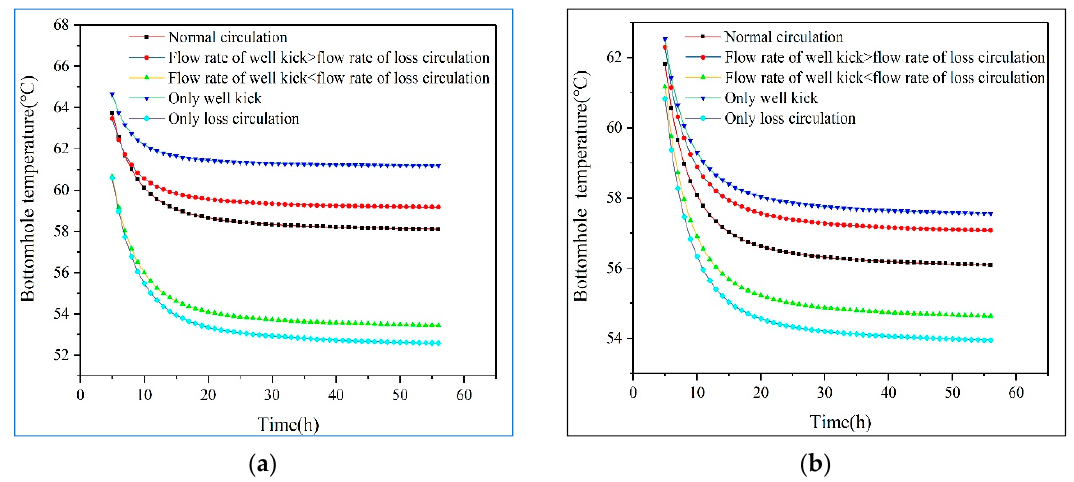
Figure 10. Bottom-hole temperature when multi-pressure system, only overflow or only leakage occurs; ( a , b ) show conditions when multi-pressure system is located in middle open formation and at bottom hole, respectively.